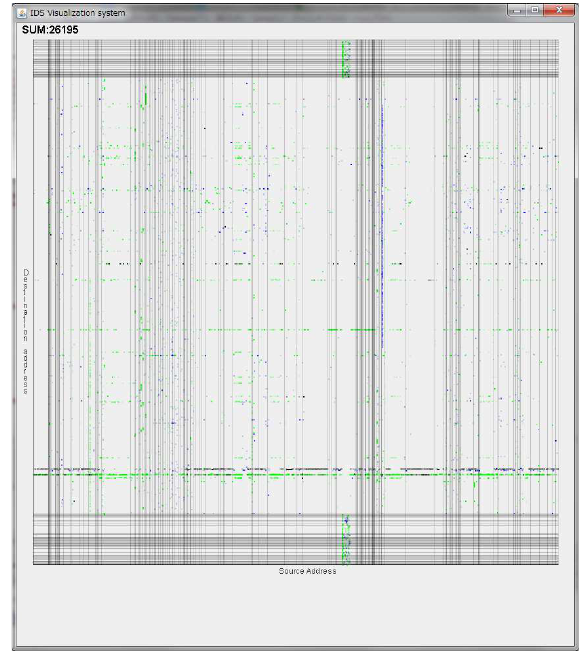
Figure 14: UnEqual Scaling visualization system without emphasizing anomalous events.